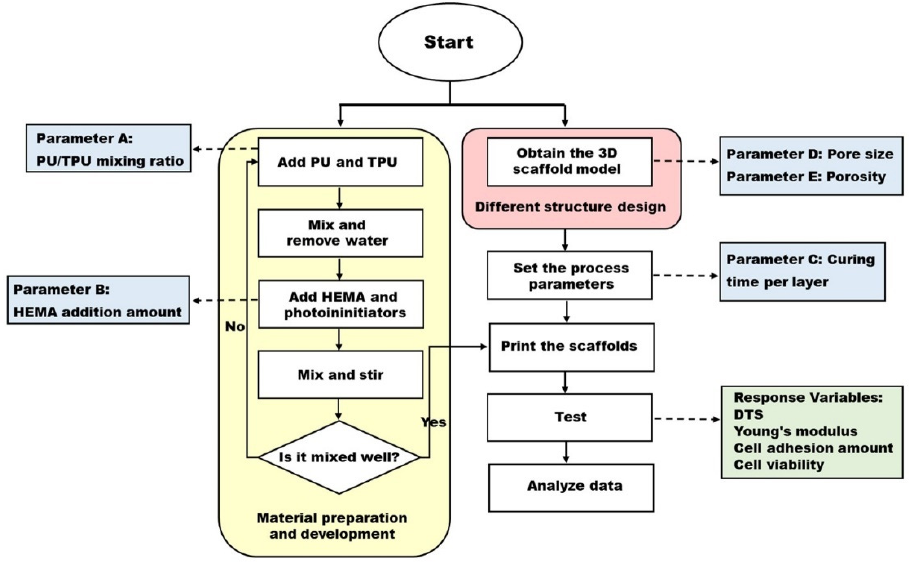
Figure 2. Flow chart of the experiments.